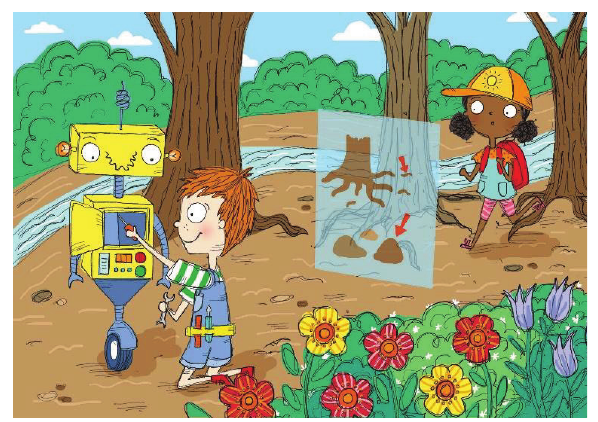
FIGURE 4: Kate’s screen/lens, Ben’s toolkit and Alex’s input screen. BOX 1: Alex the robot reacts on input. In the stories, Alex the robot has a programming screen on its ‘chest’, which allows for linguistic input. The little robot reacts to input and follows the instructions given by Ben (with his toolkit), which was designed by Kate (visible on her screen/ lens). When Ben does not provide the correct input, the output (which in a sense represents conceptual understanding) malfunctions – the robot reacts incorrectly. This idea represents what happens when children do not understand the concepts assessments, indicating limited conceptual